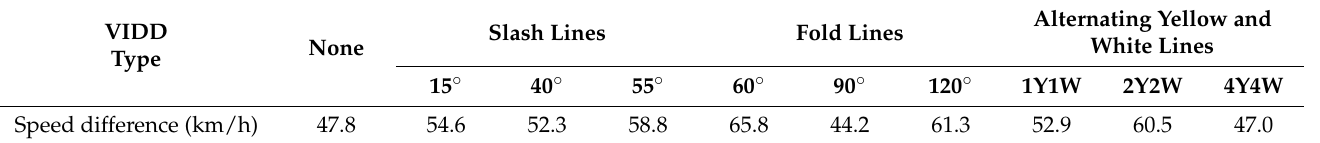
Figure 15. Minimum speeds of vehicles controlled by VIDD: ( a ) slash lines; ( b ) fold lines; ( c ) alternating yellow and white lines. Table 2. Differences between maximum and minimum speeds of vehicles with VIDDs.